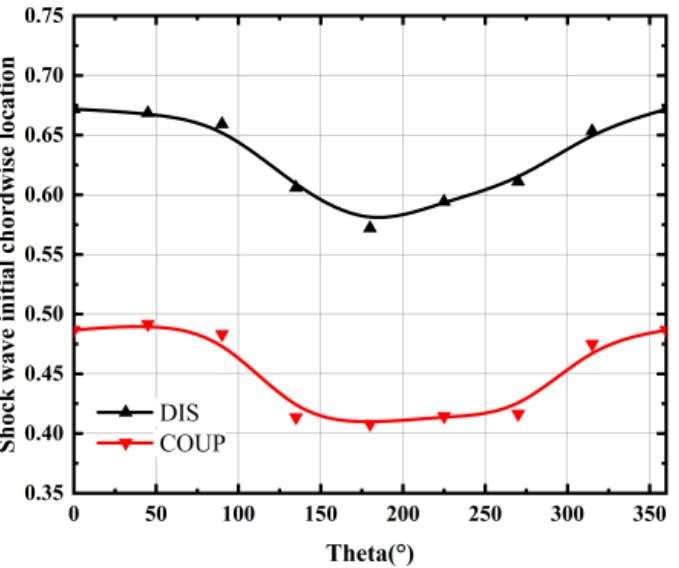
Figure 23. Comparison of the forward shift in the shock wave initial position of the blade suction surface.